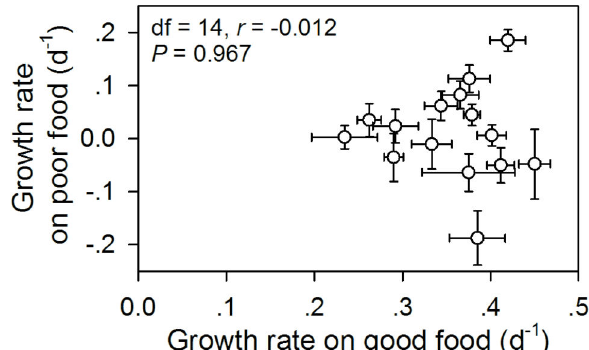
Figure 5. Growth rates of Bosmina longirostris when feeding on the “poor” diet versus that of individuals feeding on the “good” diet.